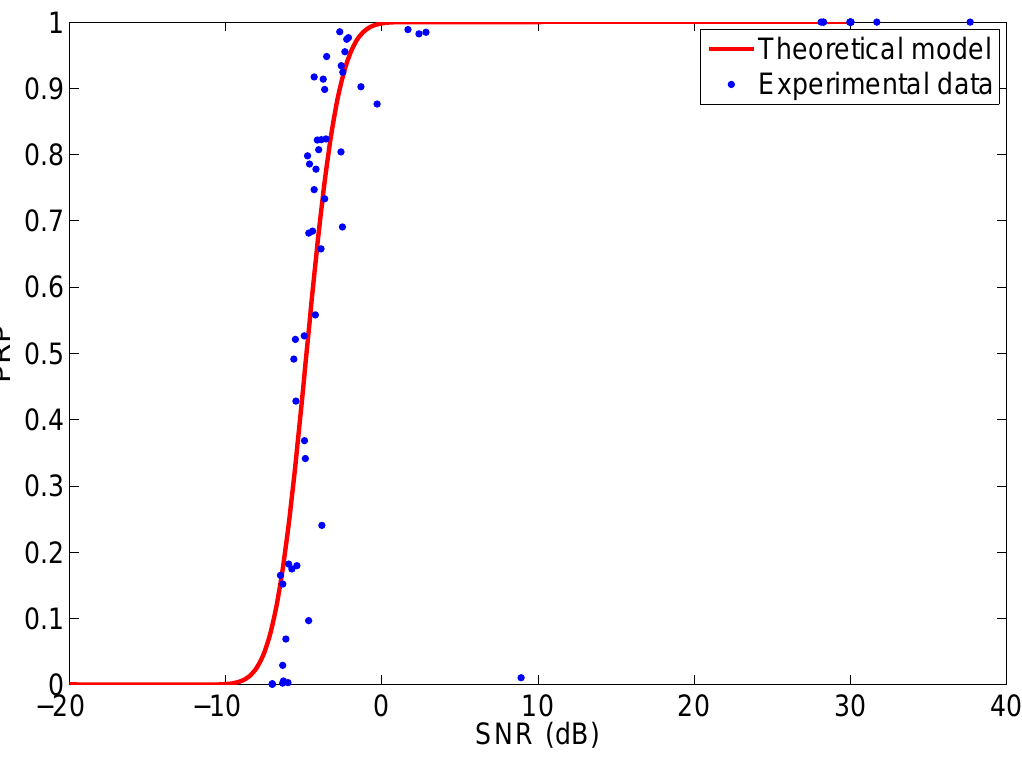
Figure 7. Relation between P RP and SNR